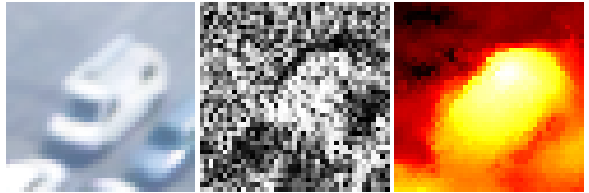
Figure 1. A crop of the van in the top right of figure 2. From left to right : RGB, SAR, DSM. The DSM is depicted in altitude. SAR and DSM are projected into RGB